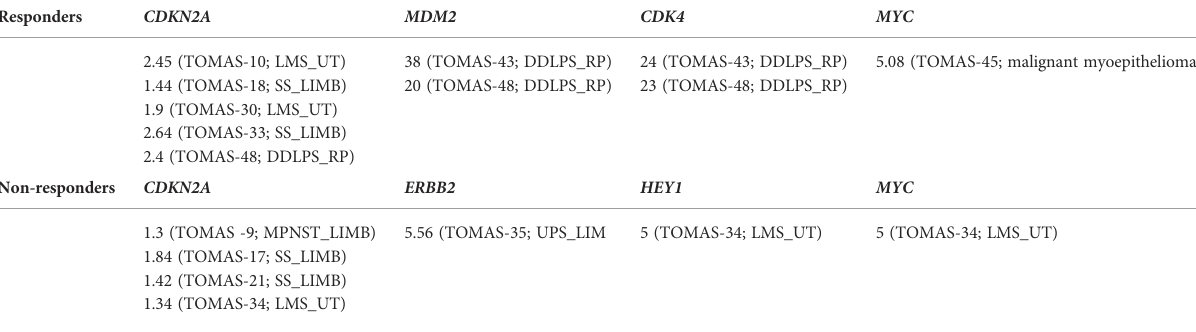
TABLE 4 Copy number differences in DDRR and related genes among responder and non-responder patients.